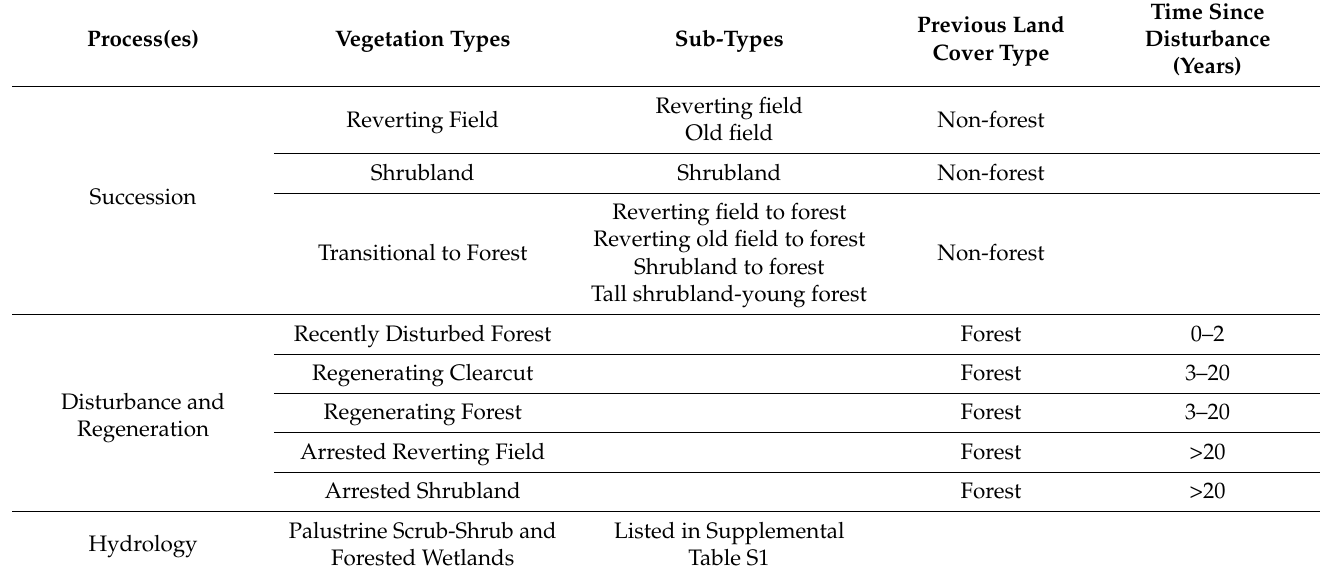
Table 1. Young forest and shrubland vegetation types are based on processes of succession, forest disturbance and regeneration, hydrology, previous land cover type, and time since disturbance.